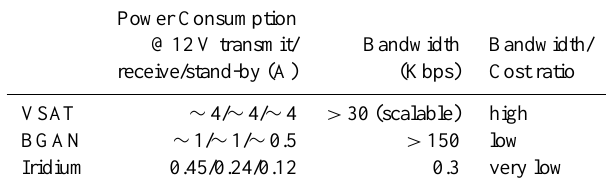
Table 2. Operational characteristics of satellite-based two-way communication systems (for power consumption, bandwidth and cost